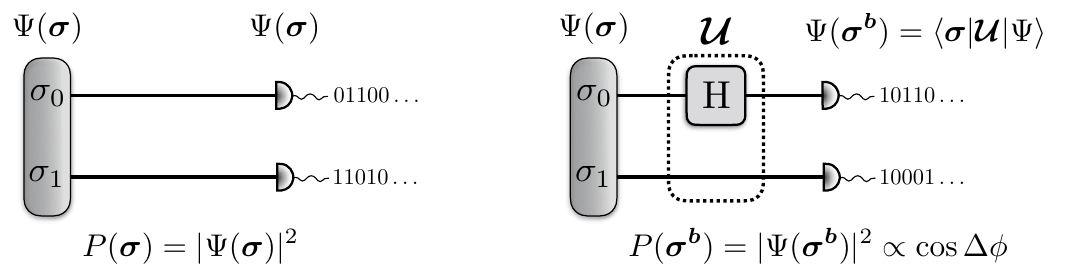
Figure 4: Unitary rotations for two qubits. (left) Measurements on the reference ba- sis. (right) Measurement in the rotated basis. The unitary rotation (the Hadamard gate on qubit σ ) is applied after state preparation and before the projective mea- 0